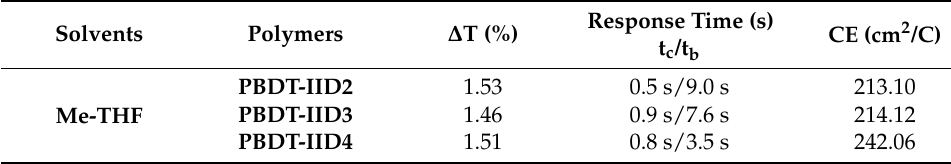
Table 4. The electrochromic properties of the